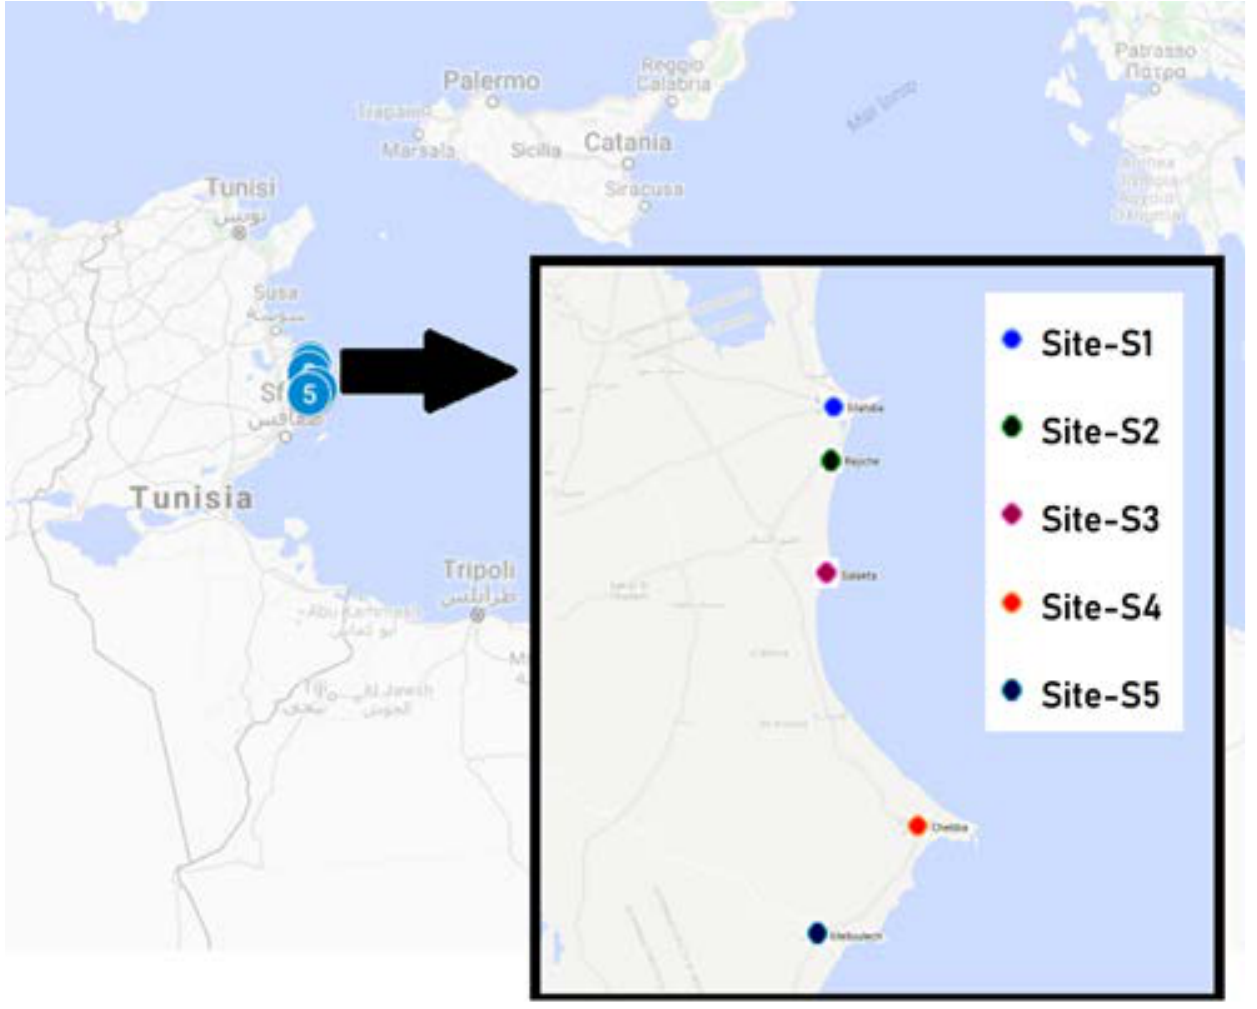
Figure 1. Sampling